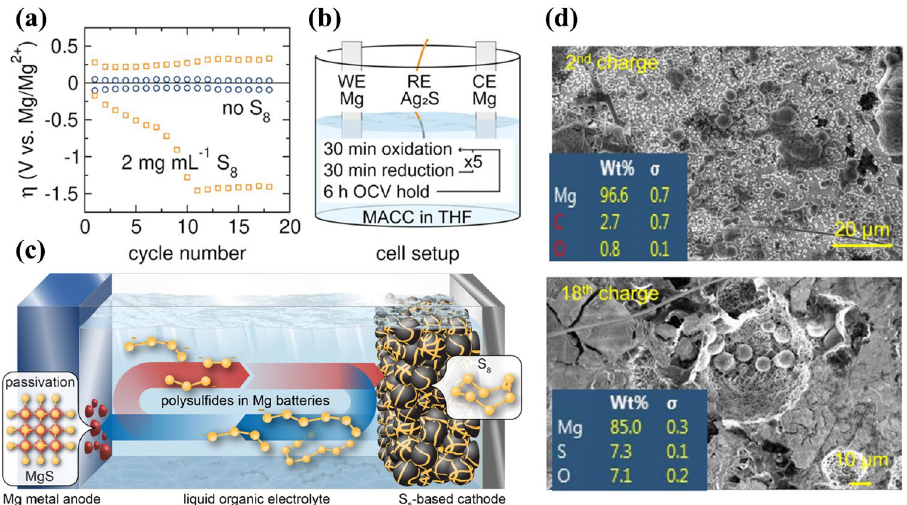
Figure 4. ( a ) Overpotential tests in Mg Symmetrical cells with and without 2 mg·mL − 1 S 8 ; ( b ) Schematic diagram of the three − electrode test; ( c ) Self − discharge and anode passivation mechanisms for Mg − S batteries [25]. ( d ) Mg foil EDS in Mg[B(hfip) 4 ] 2 electrolyte after different cycle numbers [17].